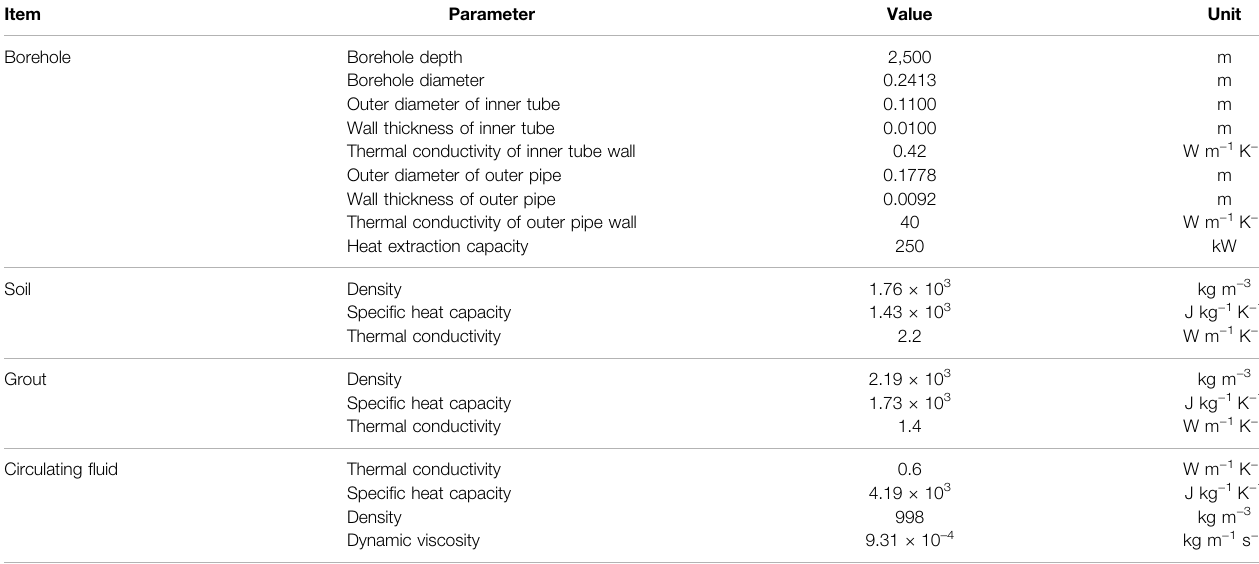
TABLE 1 | Detailed parameters of the simulated DBHE for both OpenGeoSys and Beier ’ s model